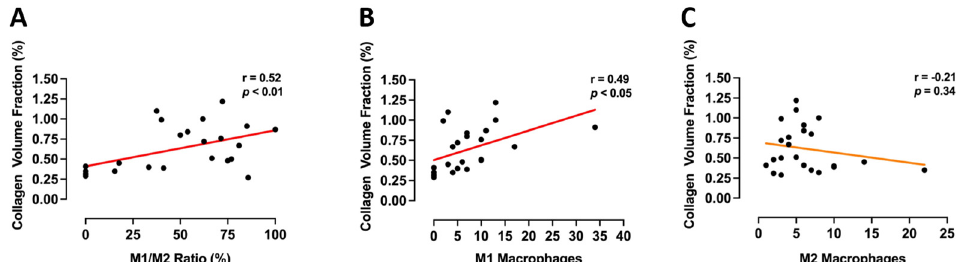
Figure 6. Macrophage phenotype associates with collagen volume fraction. Pearson’s correlations for ( A ) M1/M2 ratio; ( B ) M1 (Mac-2 + CD86 + ) macrophages; and ( C ) M2 (CD206 + ) macrophages with collagen volume fraction in hearts from Cont, Lepr db/db + saline, and Lepr db/db + SP mice. Individual data points for all groups were included and analysed by Pearson correlation co-efficient.